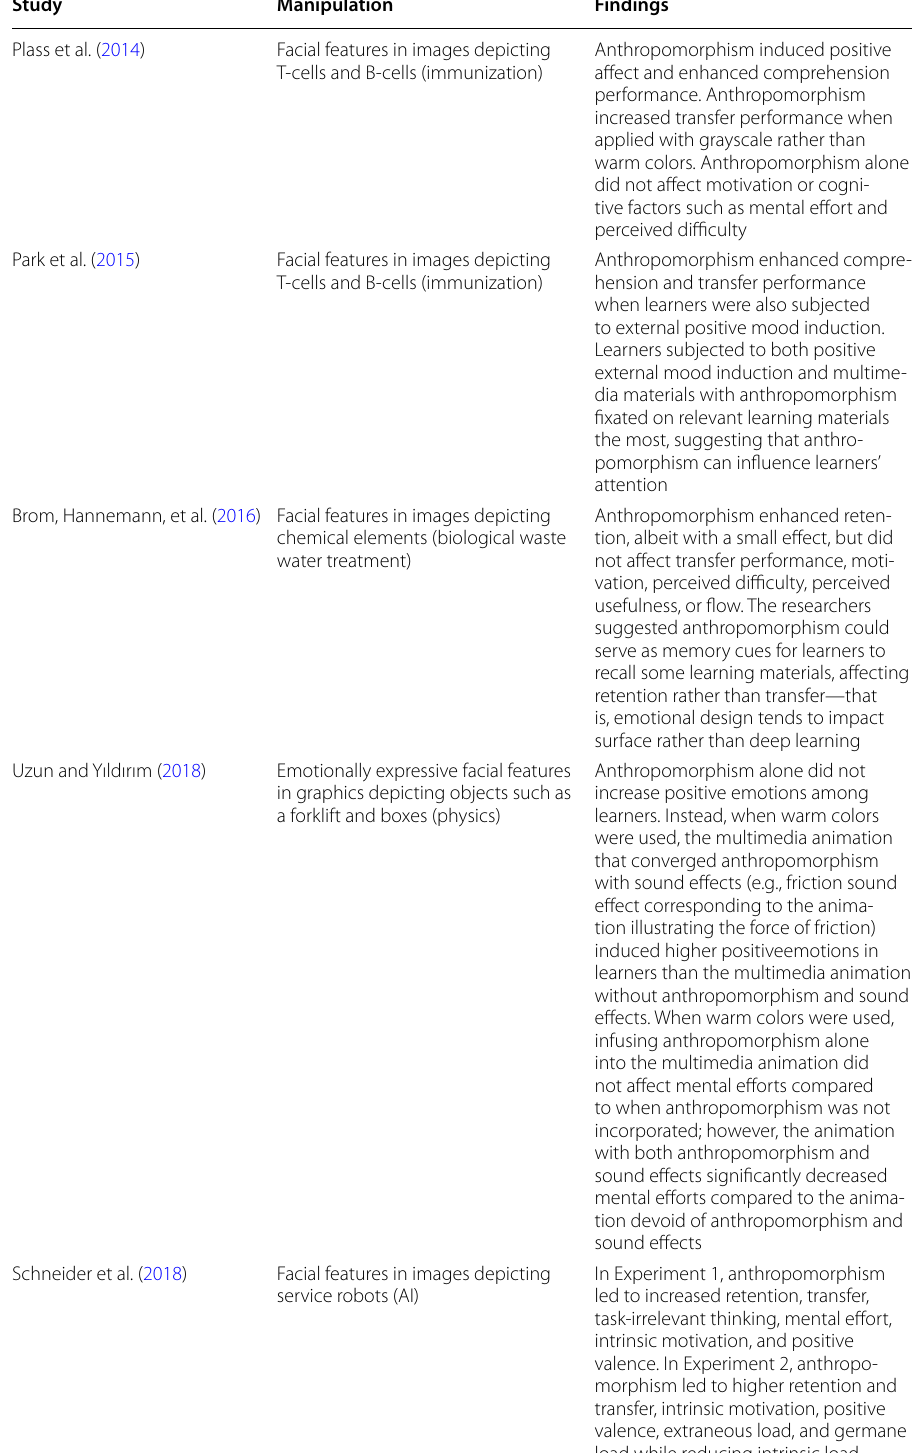
Table 1 Studies on anthropomorphism via human‑like images in multimedia learning materials